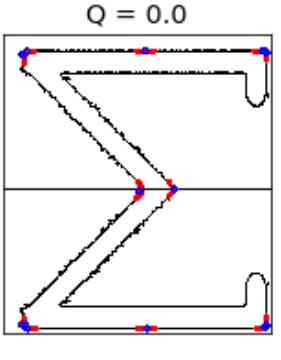
Figure 1. Convex hull based points. Blue points are hull vertices and points between middles of hull edges and object center. Red points are their nearest neighbours. Q is the asymmetry measure.